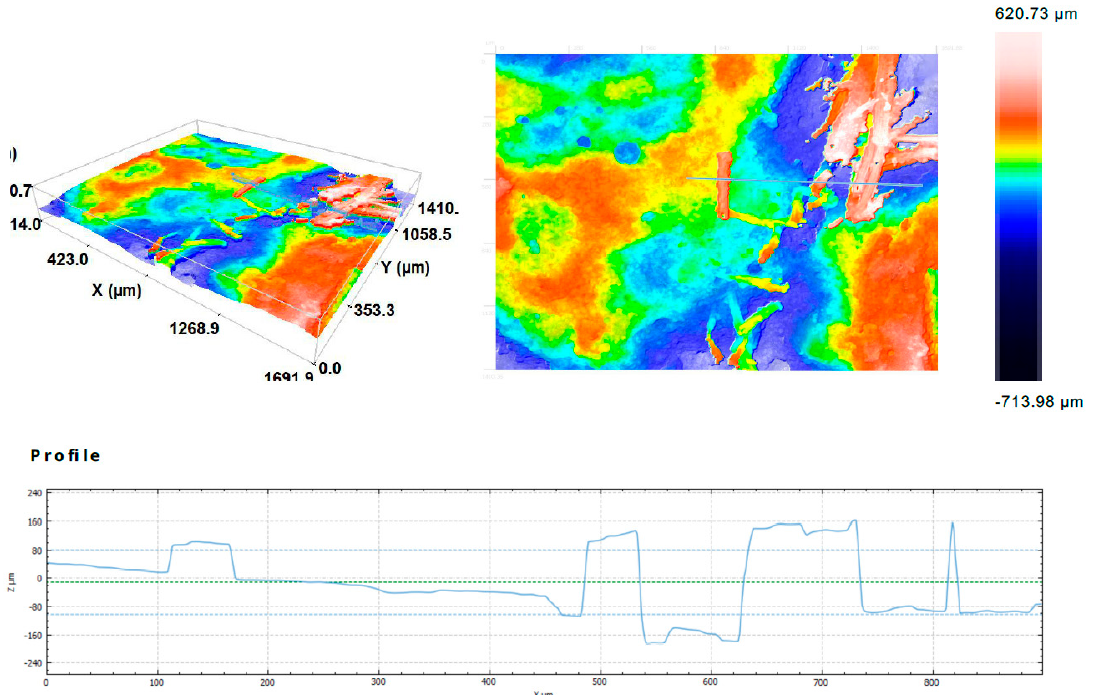
Figure 9. 3D confocal microscopy images and profile curve of the reinforced composite with flax fiber and made by simulation of additive technology.